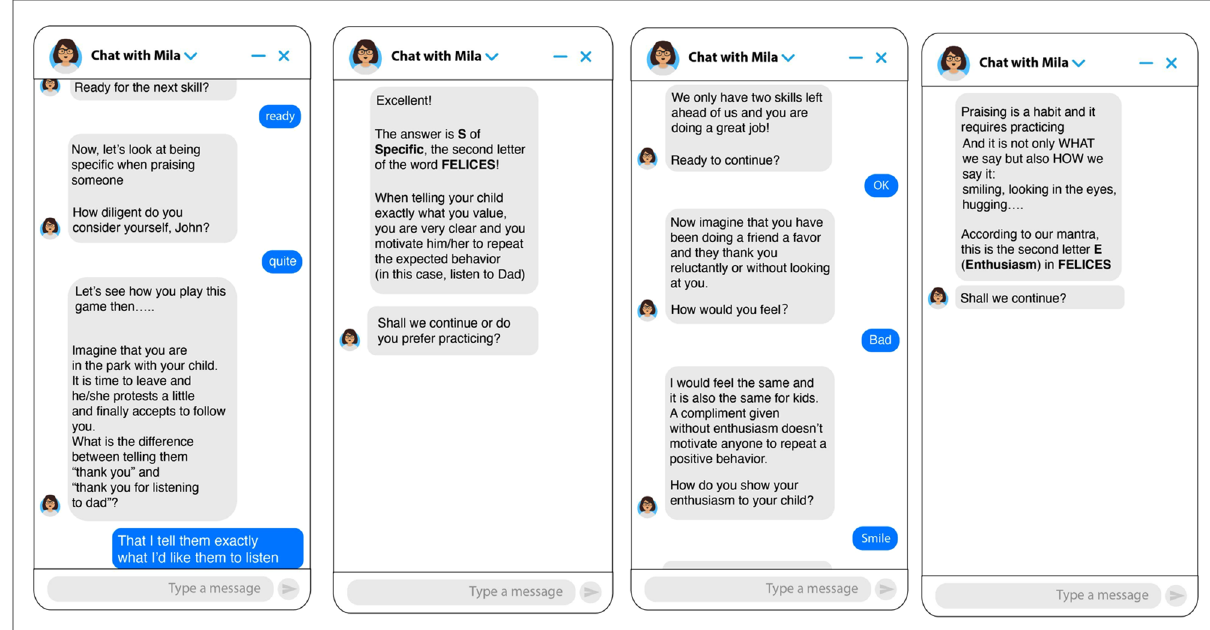
FIGURE 1 Screenshots of the chatbot for the “ Speci fi c ” and “ Enthusiasm ” skills. Note. Images on the left show skill 1 (Speci fi c) and images on the right show skill 4